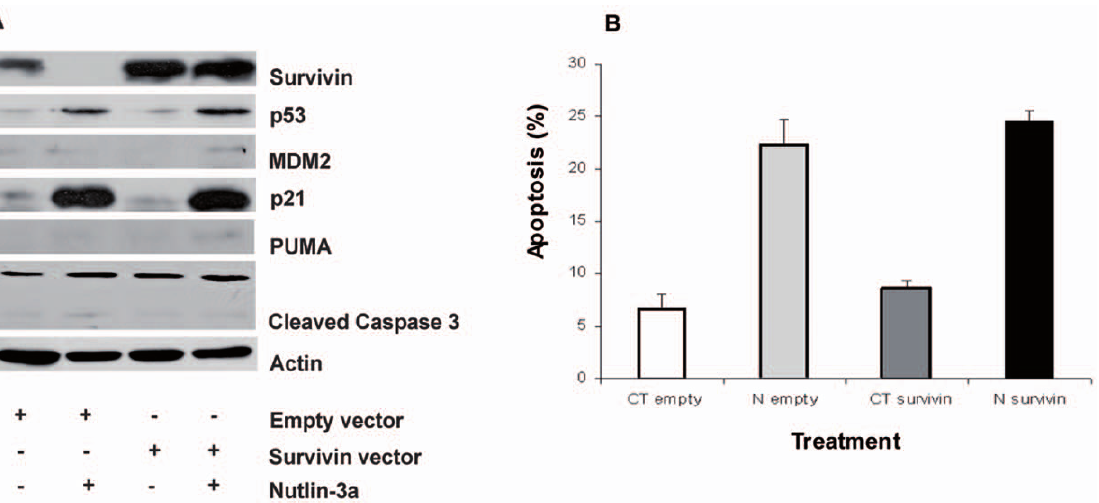
Figure 3. Ectopic overexpression of Survivin fails to suppress nutlin-3a cytotoxicity in wild-type glioma cells. A , Immunoblots were performed 48 hours after transfection and 72 hours after treatment either with DMSO or nutlin-3a. Restoration of Survivin did not prevent p53, MDM2, p21, PUMA and cleaved Caspase 3 induction after treatment with nutlin-3a; B , Induction of apoptosis in DMSO (CT) and nutlin-3a (N) treated cells 48 hours after transfection either with empty pcDNA3 (empty) or plasmid expression vector pcDNA3-Survivin (survivin) and 72 h after treatment. Apoptosis was measured by surface Annexin V staining and flow cytometry as described in ‘‘Patients, materials and methods’’. Average of a total of three independent assays 6 sd. empty: empty vector; Survivin: Survivin-expressing vector.